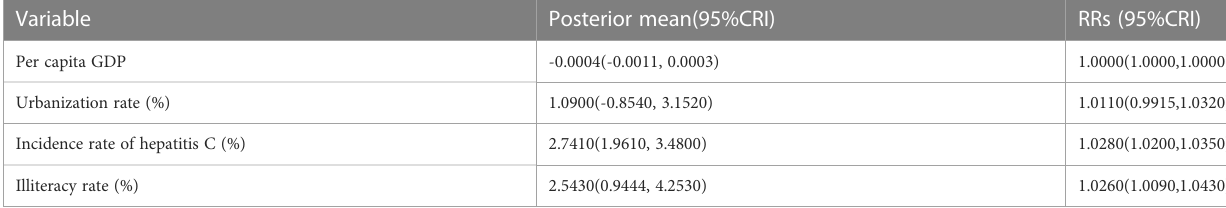
TABLE 3 Quanti fi ed posterior mean values and relative risks (RRs) of potential driving factors of hepatitis B in China from 2010 to 2018. Variable